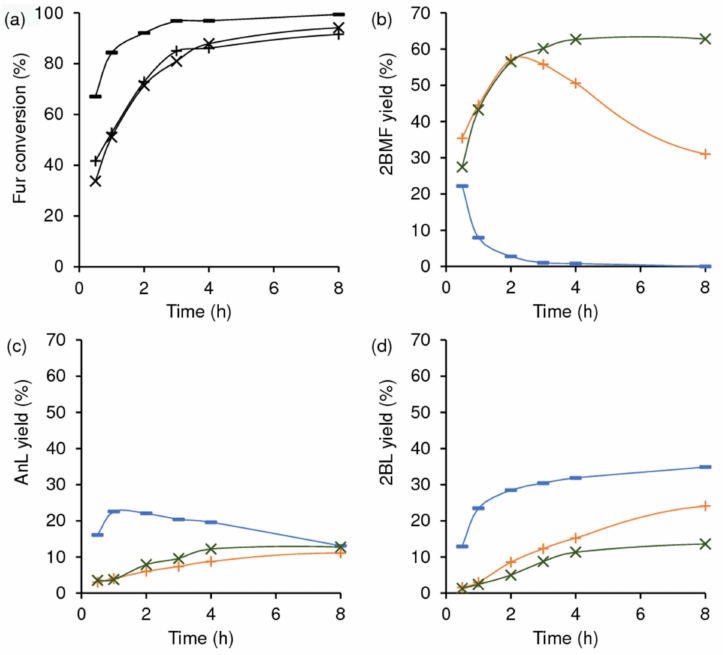
Figure 7. Influence of the molar ratio Si/Hf of the Hf-TUD-1(x) catalysts (x = 25 ( − ); x = 50 (+); x = 75 (x)) on Fur conversion ( a ) and yields of 2BMF ( b ), AnL ( c ), and 2BL ( d ) at 150 ◦ C. Reaction conditions: 0.2 M Fur in 2BuOH, 20 g cat L − 1 . Results up to 24 h and for FA and LA are given in the Supplementary